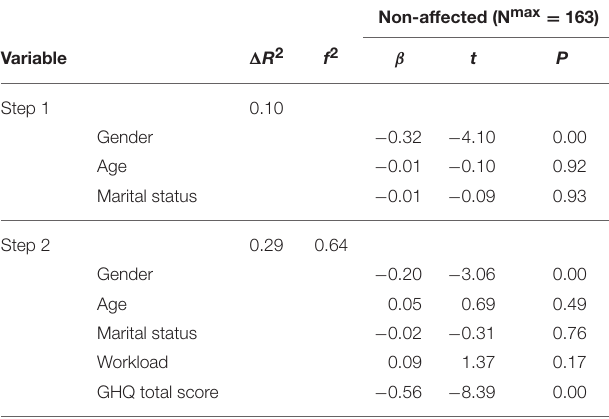
TABLE 6 | Summary of regression analyses for variables predicting job satisfaction in non-affected